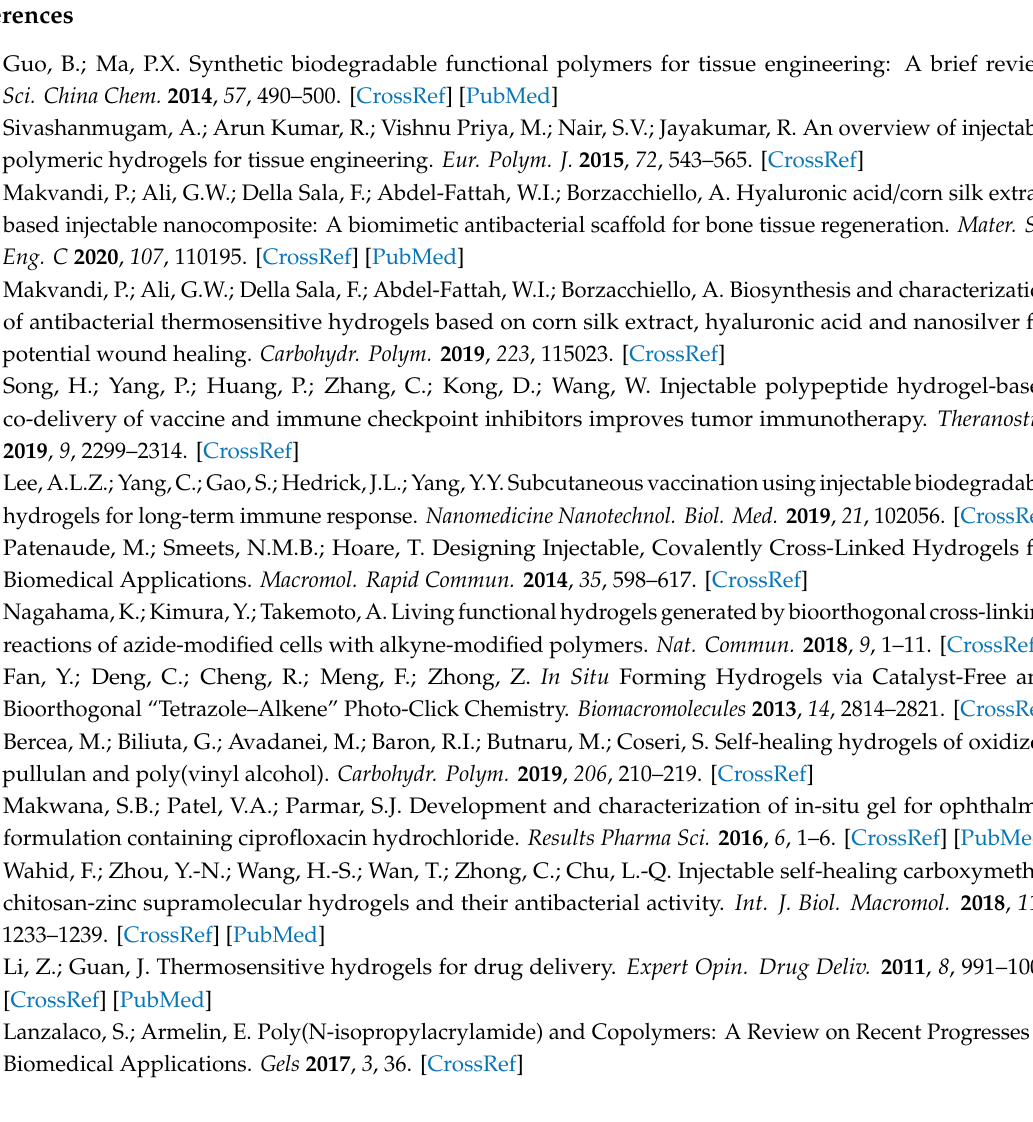
Figure S1: 1 H NMR spectrum of PLA-HEA (CDCl 3 , 400 MHz), Figure S2: 1 H NMR spectrum of PLA-SG1 (CDCl 3 , 400 MHz), Figure S3: 1 H NMR spectrum of PEGMA (CDCl 3 , 400 MHz), Figure S4: 1 H NMR spectrum of PLA-b-P(NIPAAm-co-PEGMA) (CDCl 3 , 400 MHz), Figure S5: 1 H NMR spectrum of P(NIPAAm-co-PEGMA) (CDCl 3 , 400